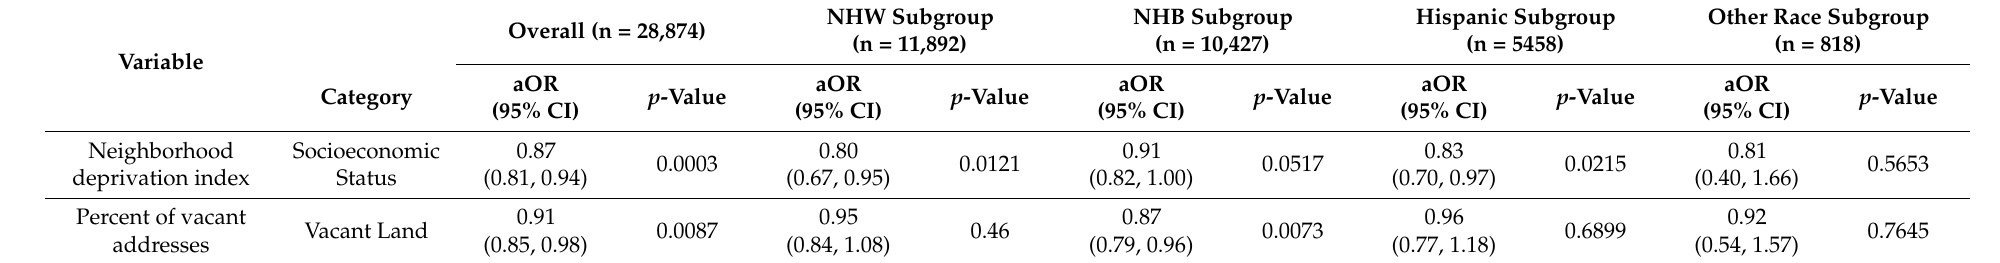
Table 4. Results from multivariate logistic regressions (with binary contextual-level social determinants of